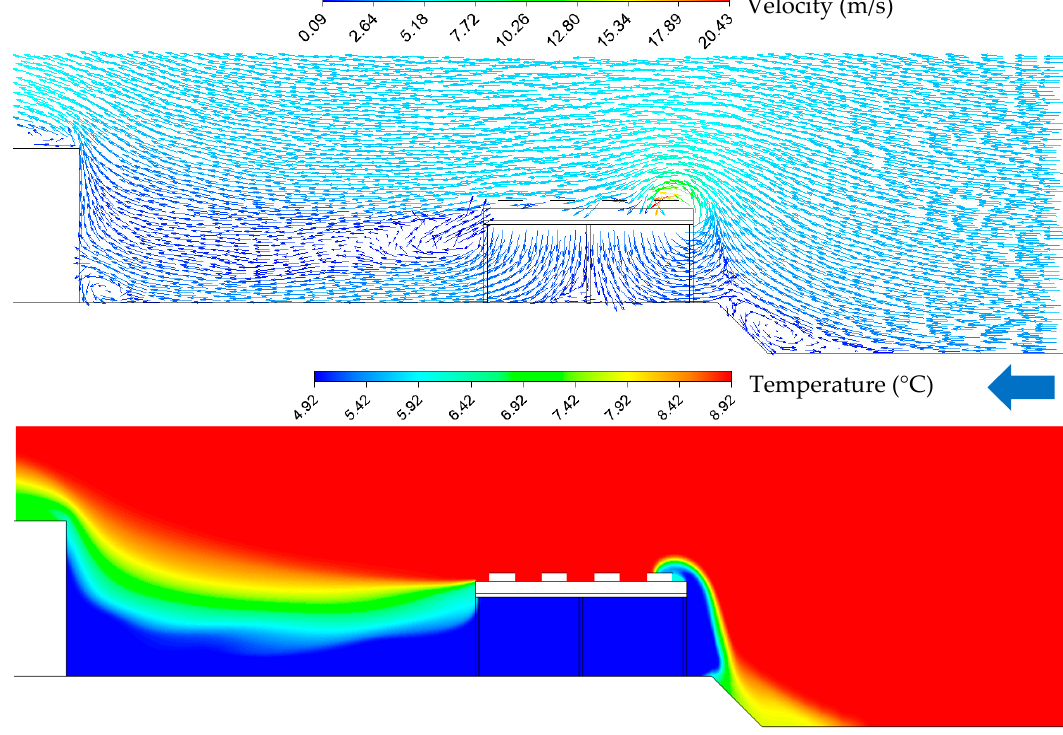
Figure 20. Velocity streamlines and temperature contour at row 17, real field and east wind condition.